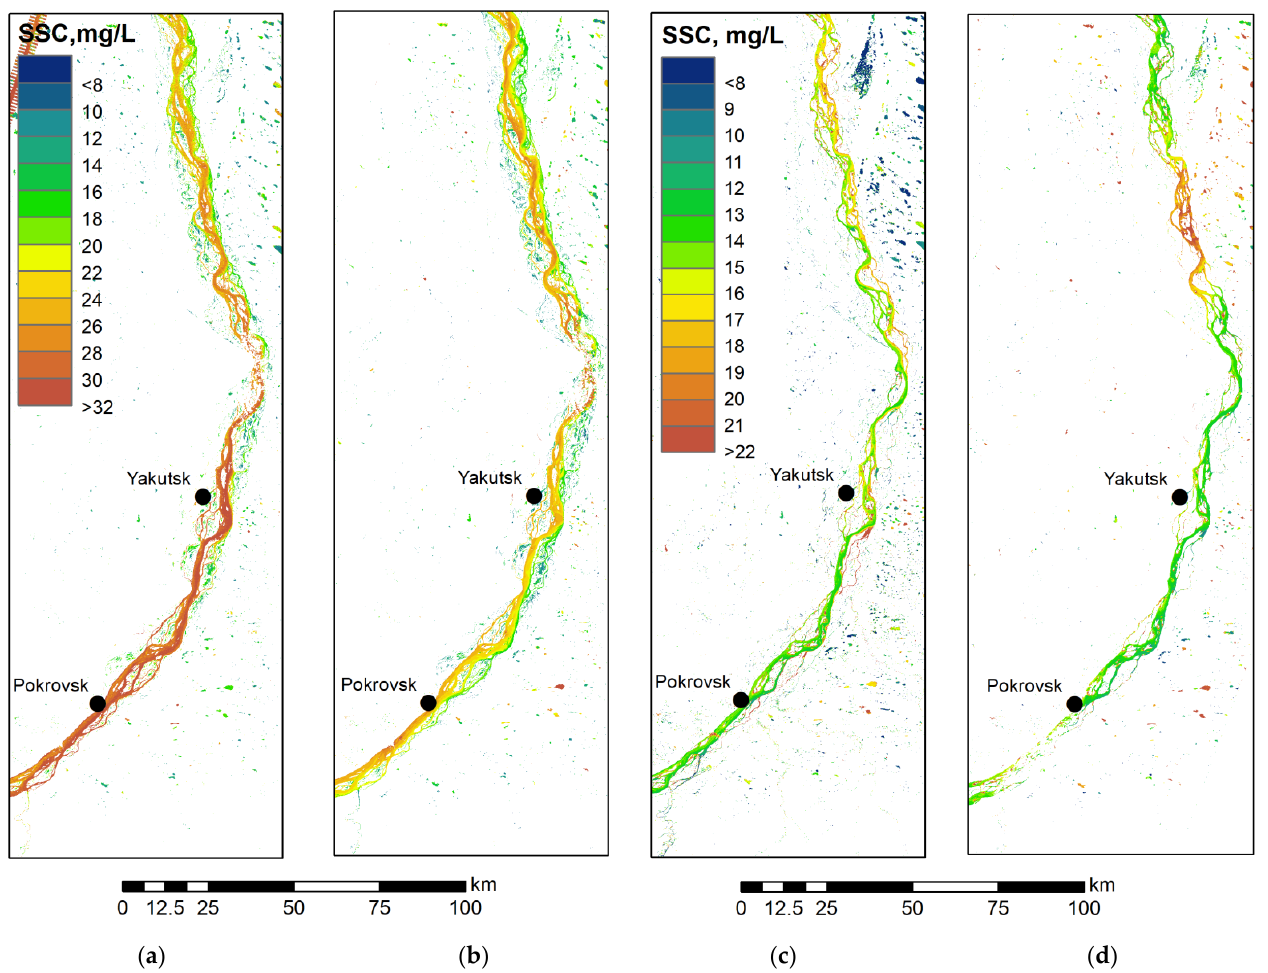
Figure 6. SSC maps for the Lena case study 1 demonstrating examples of longitudinal sediment concentration increase: ( a ) 15 June 2007 under a Lena discharge of 36,300 m 3 s −1 ; ( b ) 21 June 2021 under a Lena discharge of 24,200 m 3 s −1 ; and a decline: ( c ) 19 September 2013 under a water discharge of 8680 m 3 s −1 ; ( d ) 30 July 2021 under a Lena discharge of 9480 m 3 s −1 .